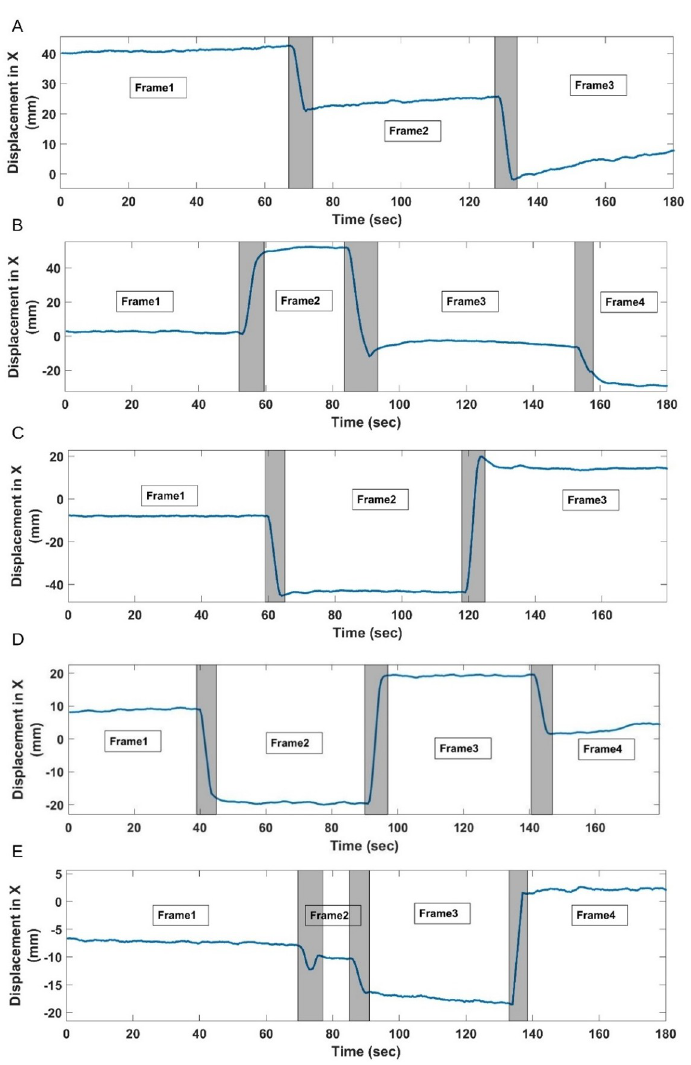
Fig 3. Motion segment extraction. Plots of motion in principal direction along with the estimated transitional and static frames: (A) Patient Study 1: Three static frames; (B) Patient Study 2: Four static frames; (C) Patient Study 3: Three static frames; (D) Patient Study 4: Four static frames; and (E) Patient Study 5: Four static frames.